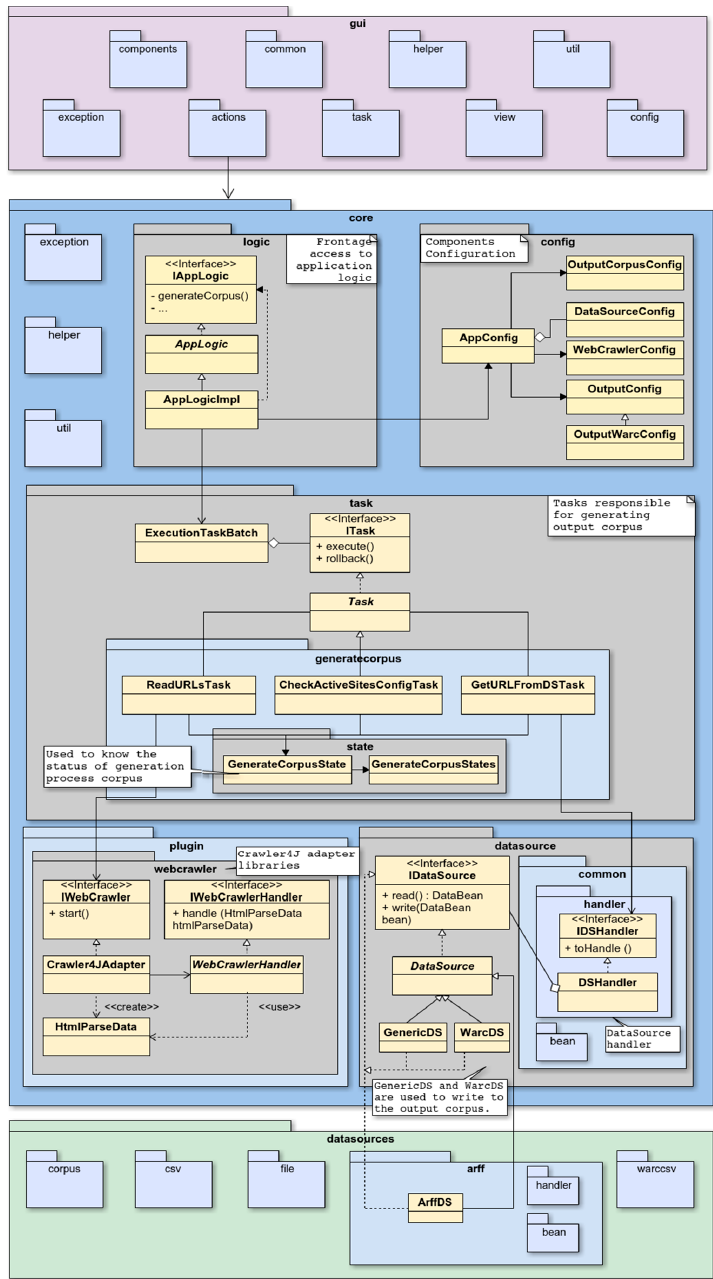
Figure 4. WARCProcessor package structure.